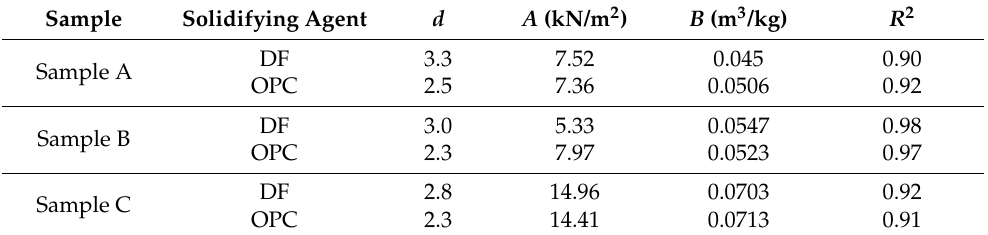
Table 4. Parameters A , B , and d of Equation (4) for stabilized